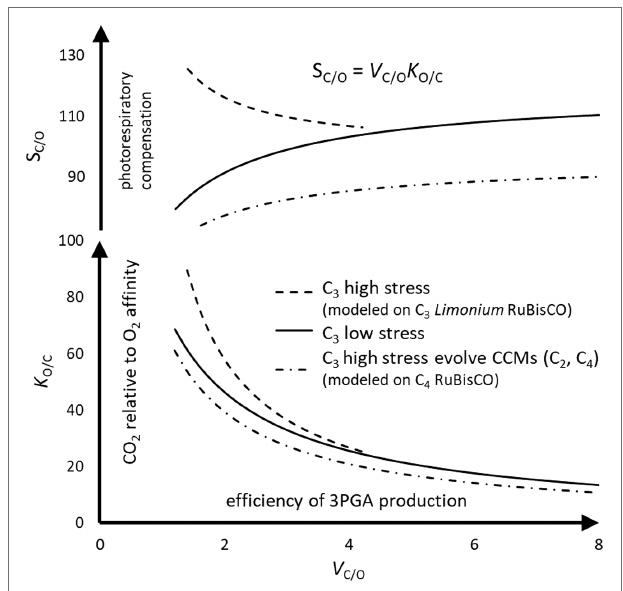
FIGURE 7 | The effect of abiotic environmental stress on RuBisCO kinetics in C 3 plants. The trend lines ( Figure 2H ) in relative specificity, S C/O , are obtained by the product of V C/O = V C / V O , a measure of 3PGA product turnover efficiency, and K O/C = K O / K C , a measure of CO 2 relative to O 2 affinity for enolizied RuBP. The efficiency of C 3 photosynthesis also relies on the constant supply of CO 2 to RuBisCO, which photorespiration can help maintain. Abiotic stress factors increase the photorespiration relative to photosynthesis (Equation 1). Most C 3 species, with more or less average S C/O , are situated in usually low stress (or temperate) habitats; however, some level of photorespiratory CO 2 may be necessary to maintain photosynthesis during short periods of increased stress (Igamberdiev, 2015). Some C 3 plants can leverage off the additional photorespiratory CO 2 produced by their much lower than average S C/O in high stress environments (C 2 photosynthesis). Some of these C 2 plants may go on to evolve fully developed carbon concentrating mechanisms (C 4 photosynthesis). Alternatively, the much higher than average S C/O in other C 3 plants, while mitigating photorespiration, may compensate for the carbon restriction (reduced levels of chloroplast CO 2 ) associated with high stress environments by gains in CO 2 relative to O 2